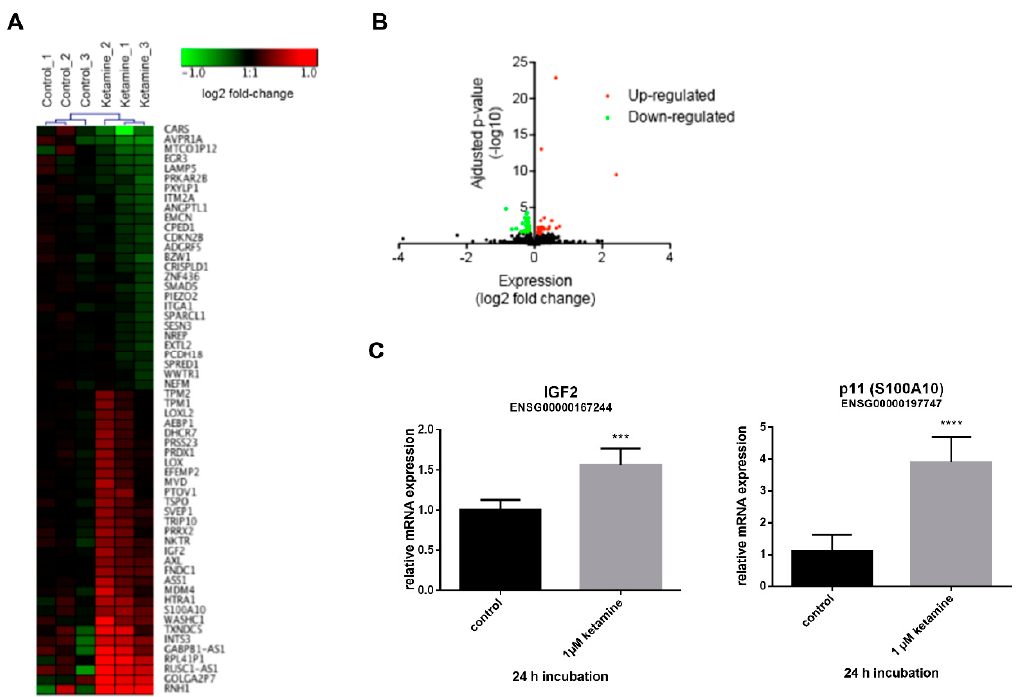
Figure 5. Differential gene expression in IMR90 NPCs after ketamine treatment. ( A ) RNA-Seq results are presented in a heat map showing differential mRNA expression. NPCs were treated with 1 µM ketamine or dimethyl sulfoxide (DMSO) control for 24 h (n = 3). ( B ) A volcano plot showing differentially expressed mRNAs. Thirty-one genes were upregulated (red), and 29 genes were downregulated (green) after ketamine treatment. ( C ) Confirmation of RNA-Seq data for insulin-like growth factor 2 (IGF2) and p11 by qPCR. Expression values were calculated according to the 2 −ΔΔ CT method. Data represent the means of three independent experiments. Error bars were calculated using ±SEM. p -values were calculated against the 0.01% DMSO control.